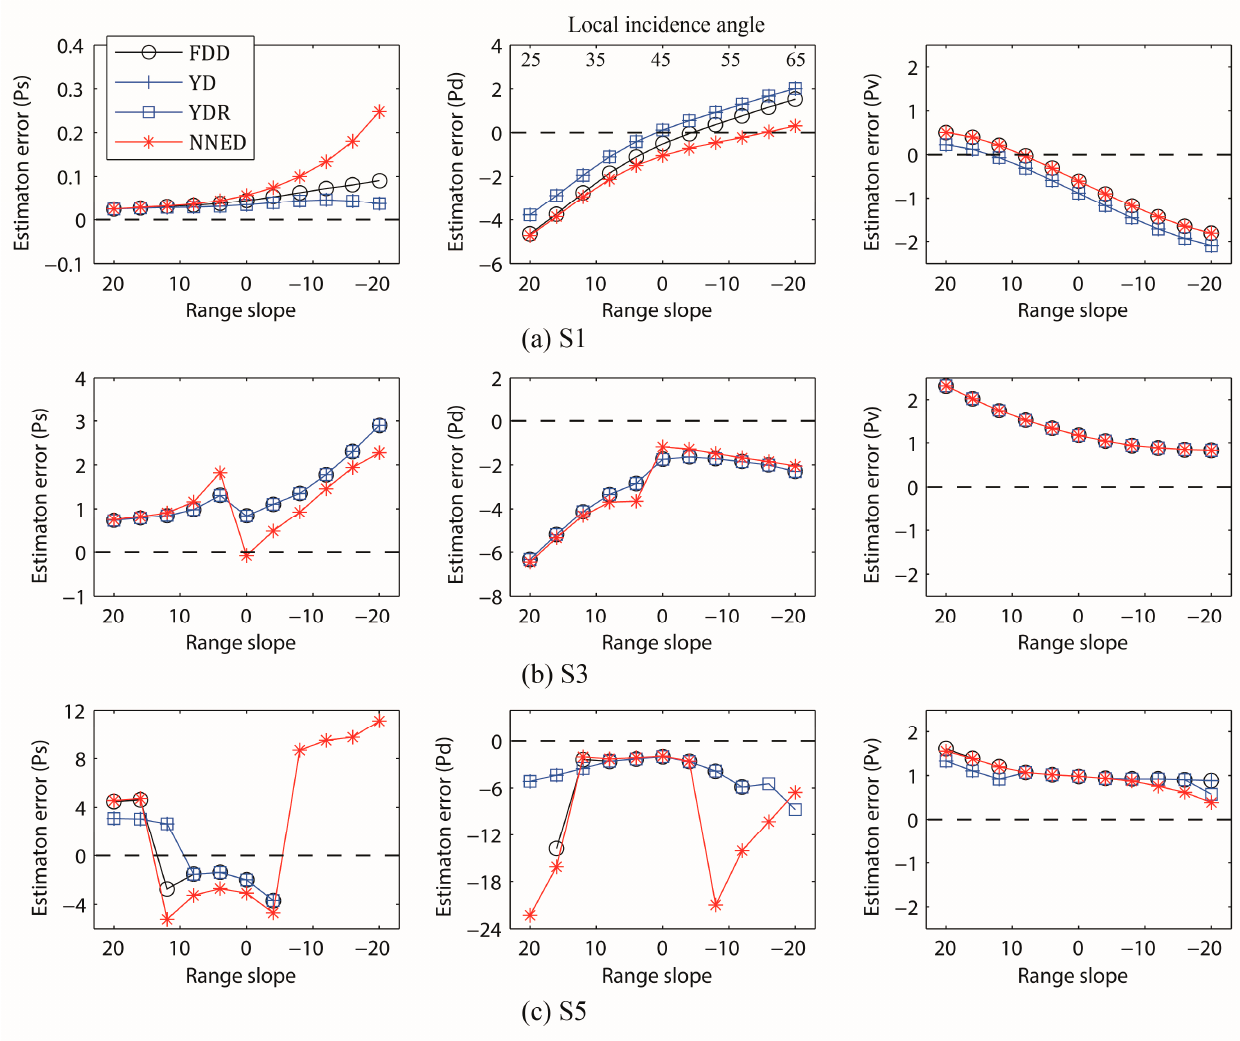
Figure 5. Estimation errors (in dB) of model-fitting-based decomposition methods with respect to the range slope angle. The first, second and third row are errors for three different size categories: ( a ) S1, ( b ) S3, and ( c )